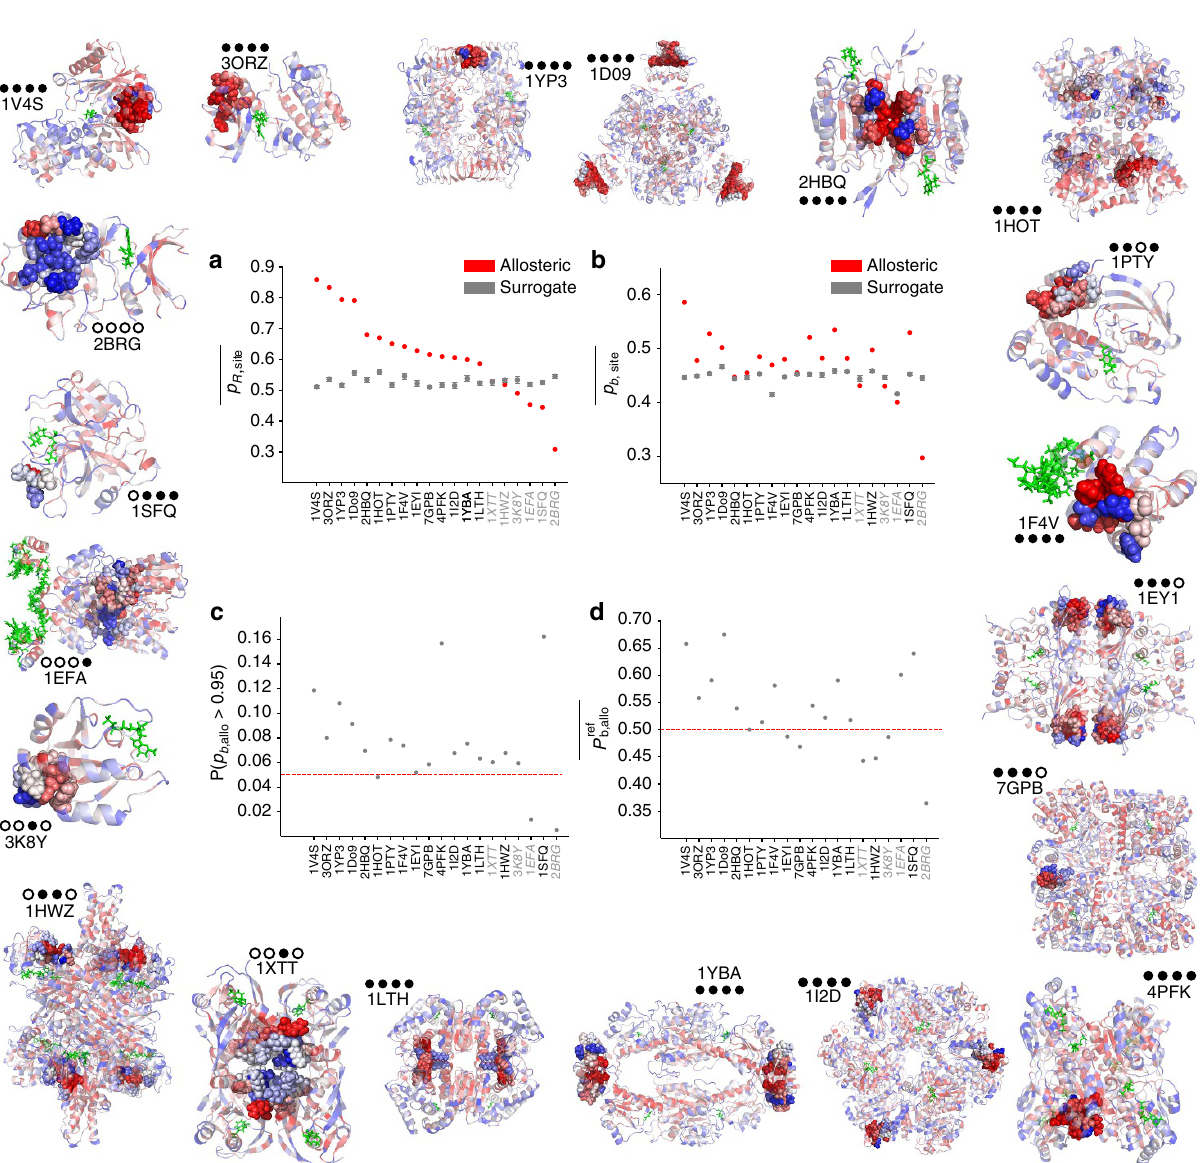
to their location. Our propensity measure identifies bonds that are strongly coupled to the active site via communication pathways on the protein graph, even if they are separated by large geometric distances. Allosteric sites correspond to ‘hotspots’, that is, sites with high propensity to perturbations at the active site as measured by their quantile score relative to other sites in the protein at a similar distance from the active site. This